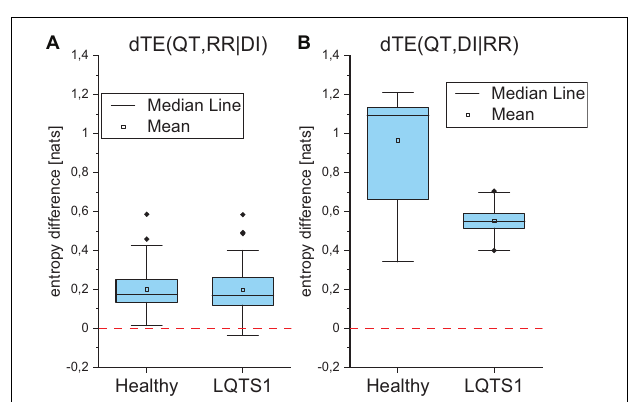
Healthy LQTS1 FIGURE 10 | (A) Conditional transfer entropy for the information flow between repolarization (QT) and heart rhythm (RR intervals) given the diastolic intervals (DIs) for healthy individuals and for LQTS1 patients. (B) Conditional transfer entropy for the information flow between repolarization (QT) and the DIs given the heart rhythm (RR intervals) for healthy individuals and for LQTS1 patients. p-Values: dTE(QT,RR| DI): 0.52989, dTE(QT,DI| RR):